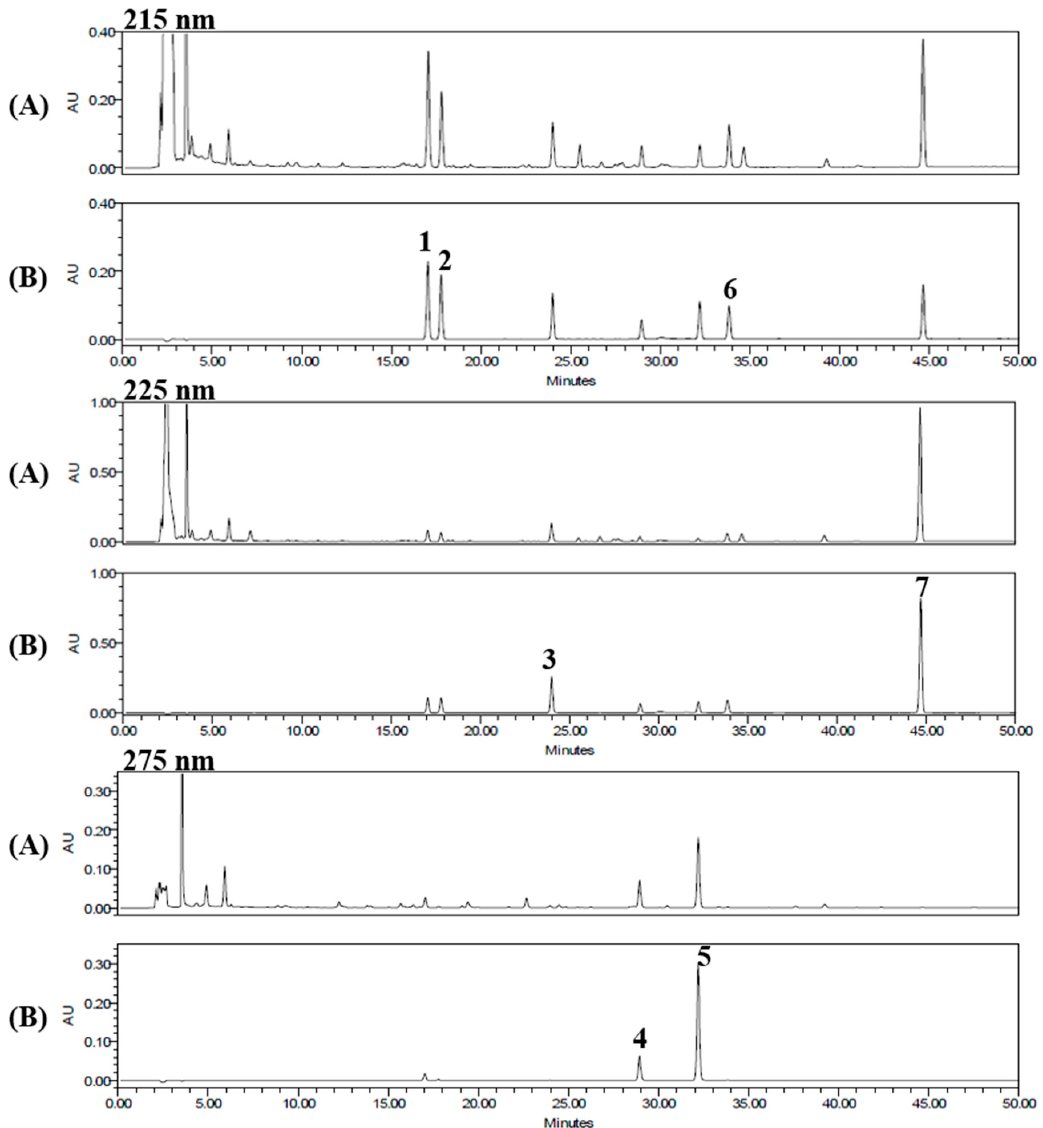
Figure 2. HPLC chromatograms of the 70% ethanol extract of P. corylifolia seeds ( A ); and its standard mixture ( B ) at 215 nm, 225 nm, and 275 nm. Psoralen ( 1 ), angelicin ( 2 ), neobavaisoflavone ( 3 ), psoralidin ( 4 ), isobavachalcone ( 5 ), bavachinin ( 6 ), and bakuchiol ( 7 ). Table 2. Linear range, regression equation, correlation coefficients, LODs, and LOQs for compounds. Compound Linear Range ( µ g/mL)